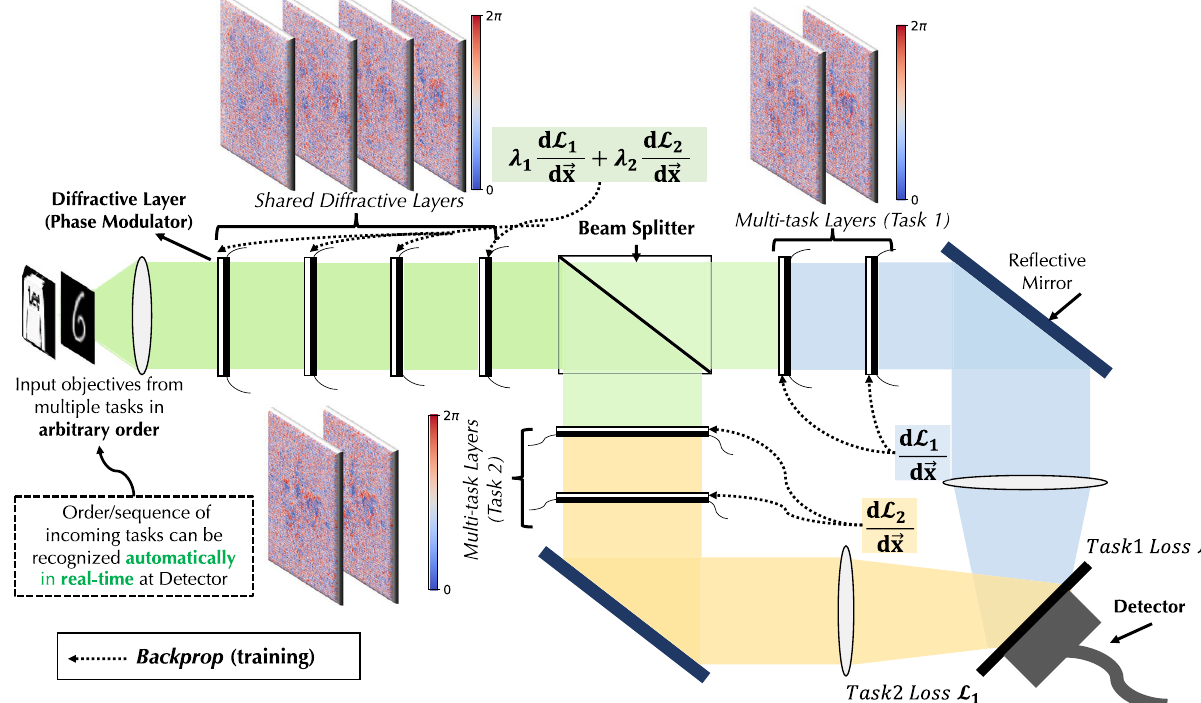
Figure 1. Illustration of multi-task deep learning and multi-task D 2 NN architecture with two image classification tasks deployed. The proposed multi-task D 2 NN architecture is formed by four shared diffractive layers and two multi-task layers, where the feed-forward computations have been re-used into multi-task layers using a beam splitter. With a novel training algorithm, the proposed architecture further reduces the hardware complexity that utilizes only ten detectors for both classification tasks, i.e., twenty different classes.